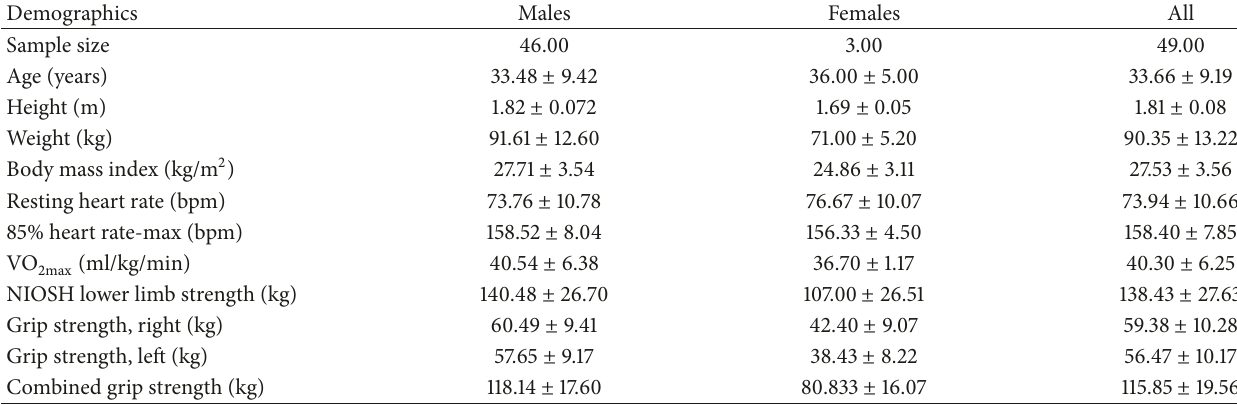
Table 1: Firefighters’ demographic